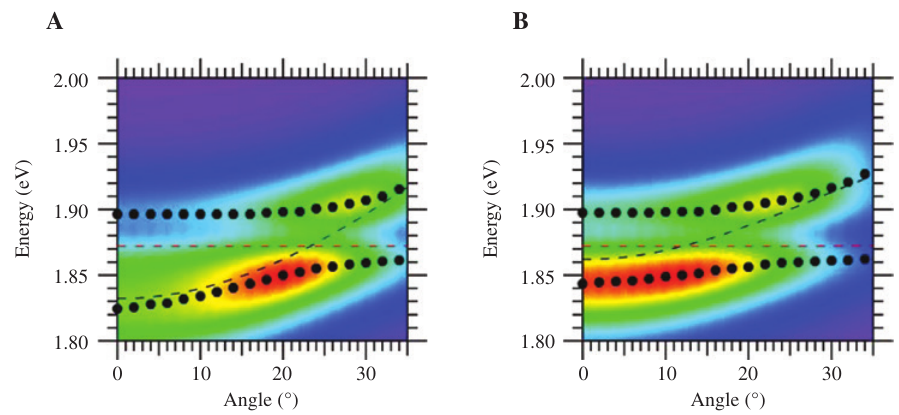
for microcavities with a detuning of −40 meV (A) and 2